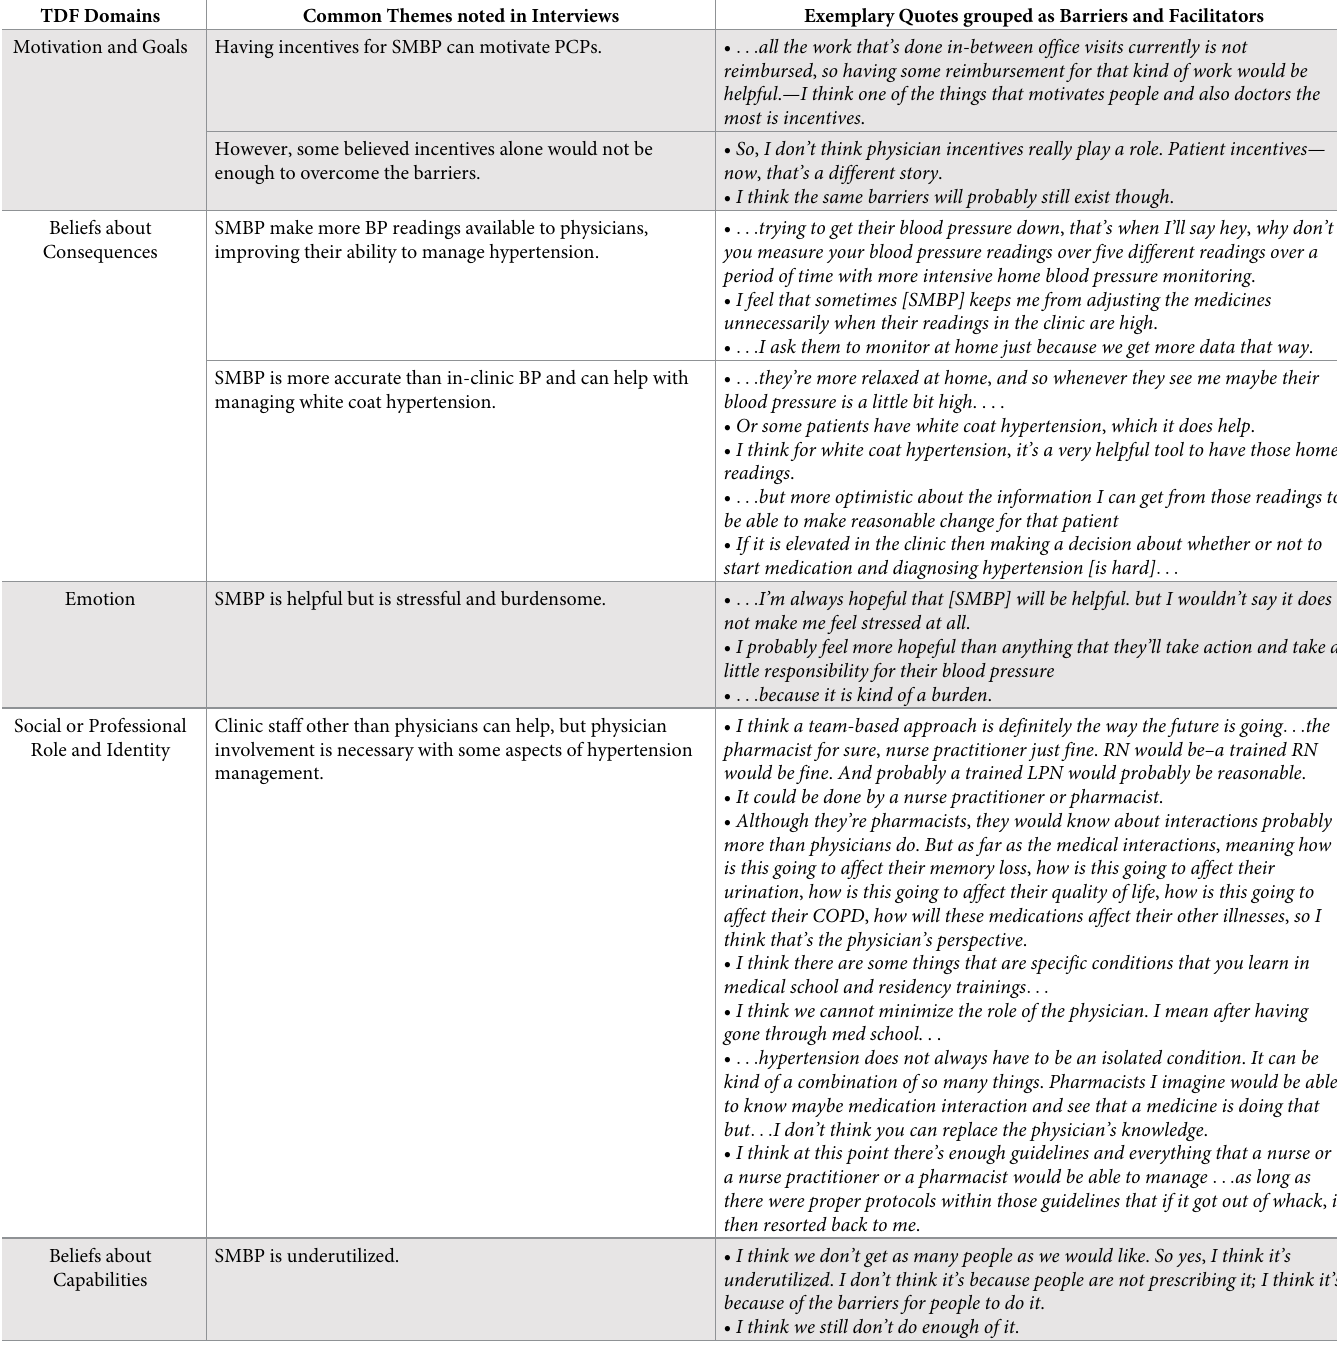
Table 2. Common themes and relevant quotes illustrating barriers and facilitators for motivation